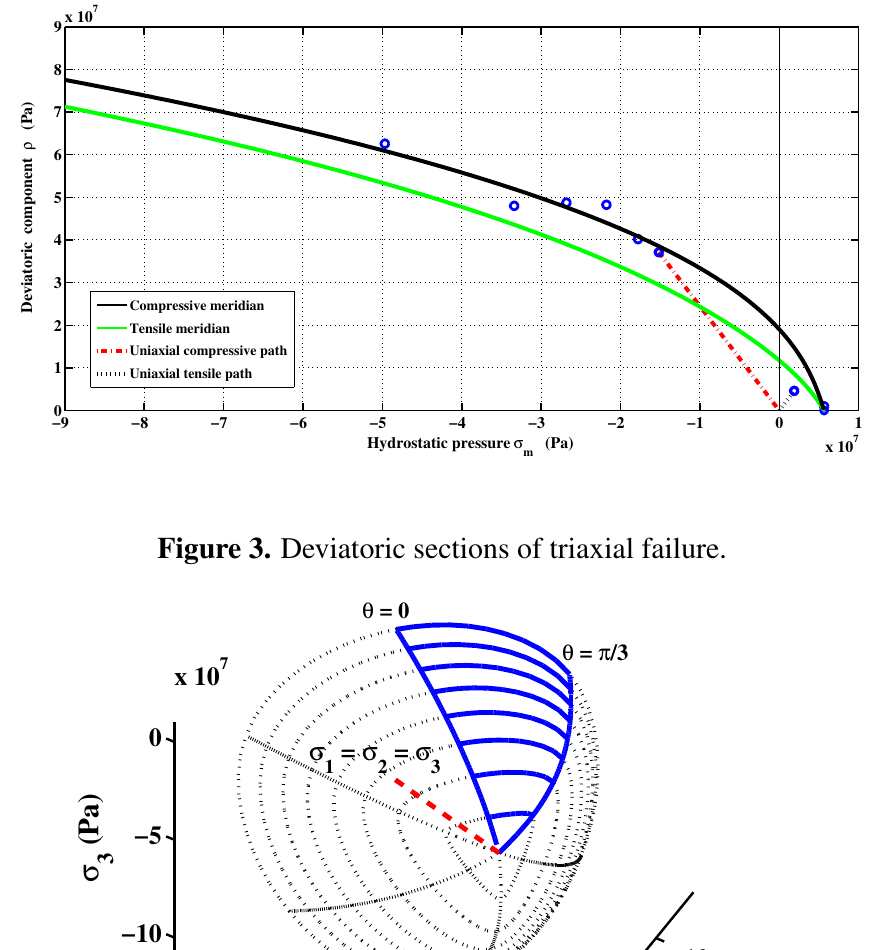
Figure 2. Meridional sections of triaxial failure.